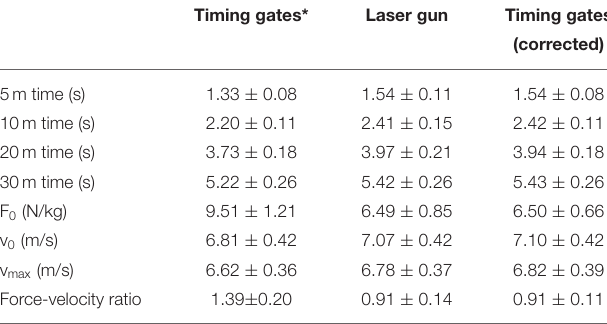
TABLE 2 | Mean ( ± SD) sprint times and mechanical sprint properties measured with the timing gates, corrected, and the laser